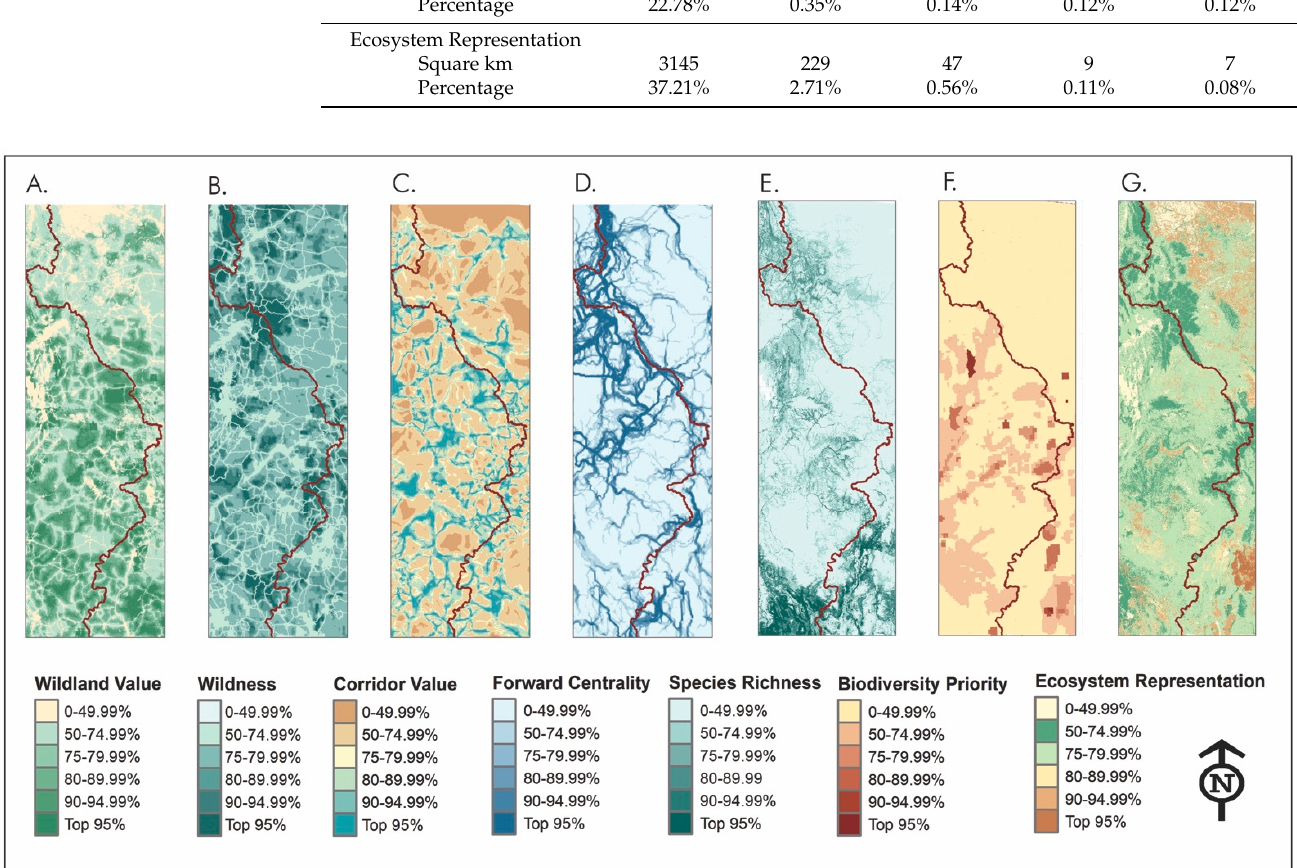
Figure 4. The conservation values of the Continental Divide Trail corridor. Bar graph to the right of each conservation value indicates the percentage of the trail that is in the top 5%, top 10%, top 20% to 25%, and top 50% of land units in the contiguous U.S. ( A ) Wildland conservation value [26]; ( B ) wildness [27]; ( C ) corridor value [5]; ( D ) forward centrality [24]; ( E ) species richness [25]; ( F ) biodiversity priority [22]; ( G ) ecosystem representation [8].